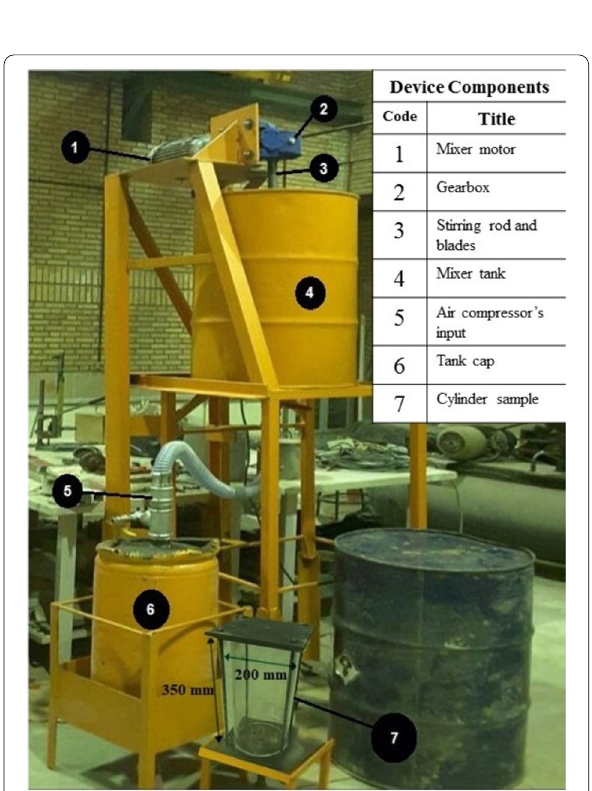
Fig. 4 Developed injection